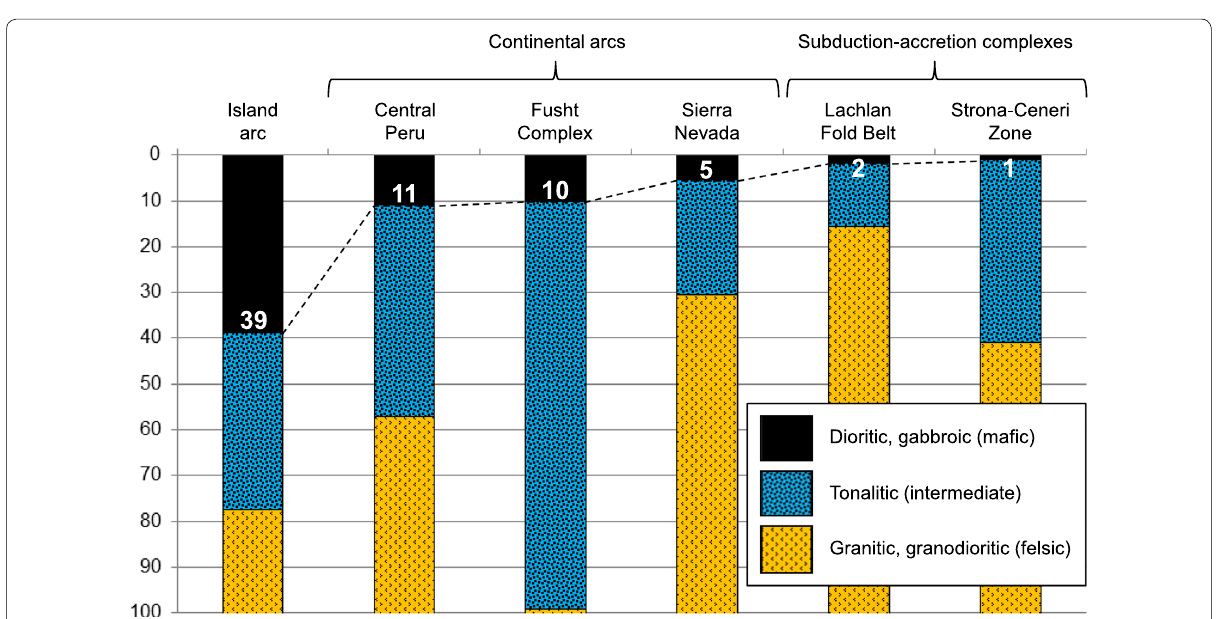
Fig. 8 AFM diagram (Irving and Baragar 1971) showing composition of banded amphibolites and garnet amphibolites of the Strona-Ceneri Zone (SCZ). Data for Grt amphibolites are from Buletti (1983). Data for dark layers of banded amphibolites are from Pinarelli et al. (2008)